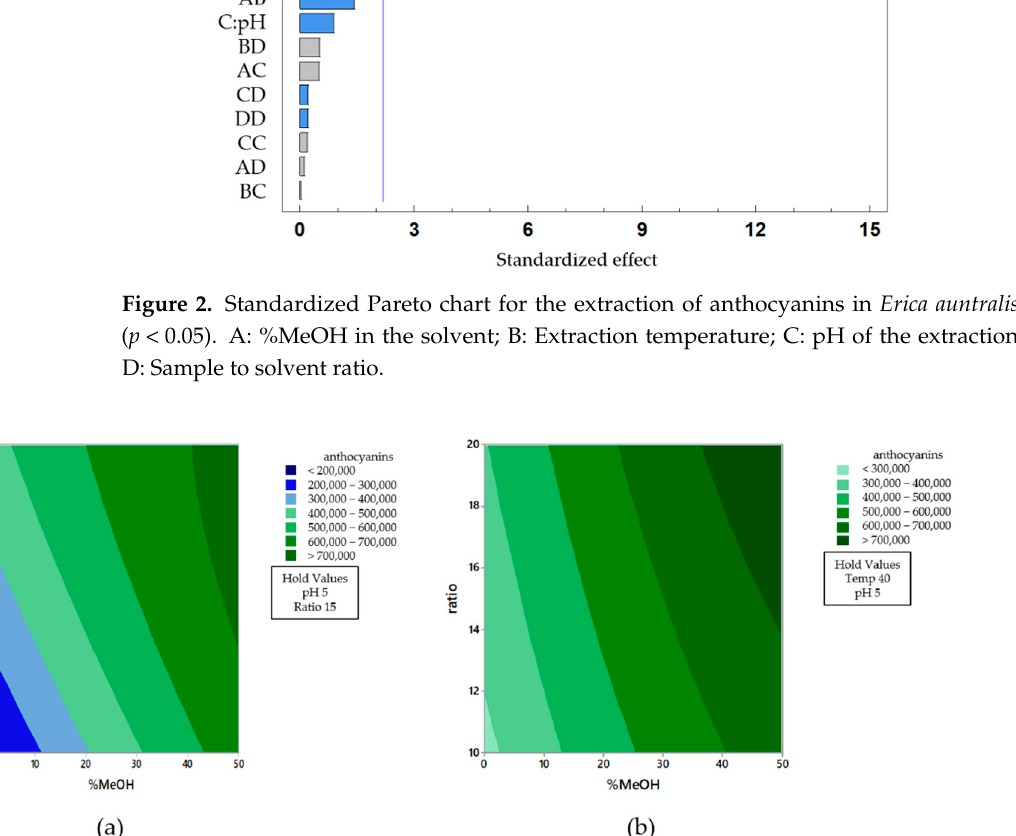
Figure 2. Standardized Pareto chart for the extraction of anthocyanins in Erica auntralis flowers ( p < 0.05). A: %MeOH in the solvent; B: Extraction temperature; C: pH of the extraction solvent; D: Sample to solvent ratio.